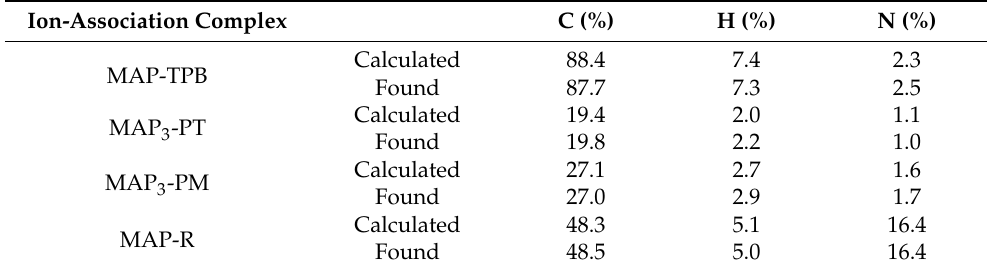
Table 1. CHN elemental analysis of ion-association